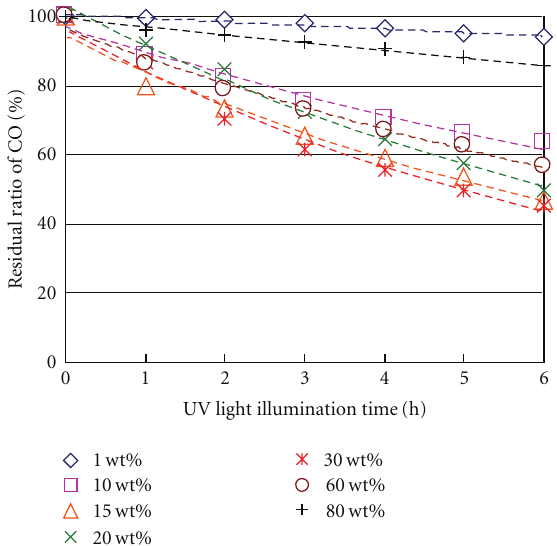
Figure 7: Residual ratio of CO for di ff erent loading ratio of TiO 2 .